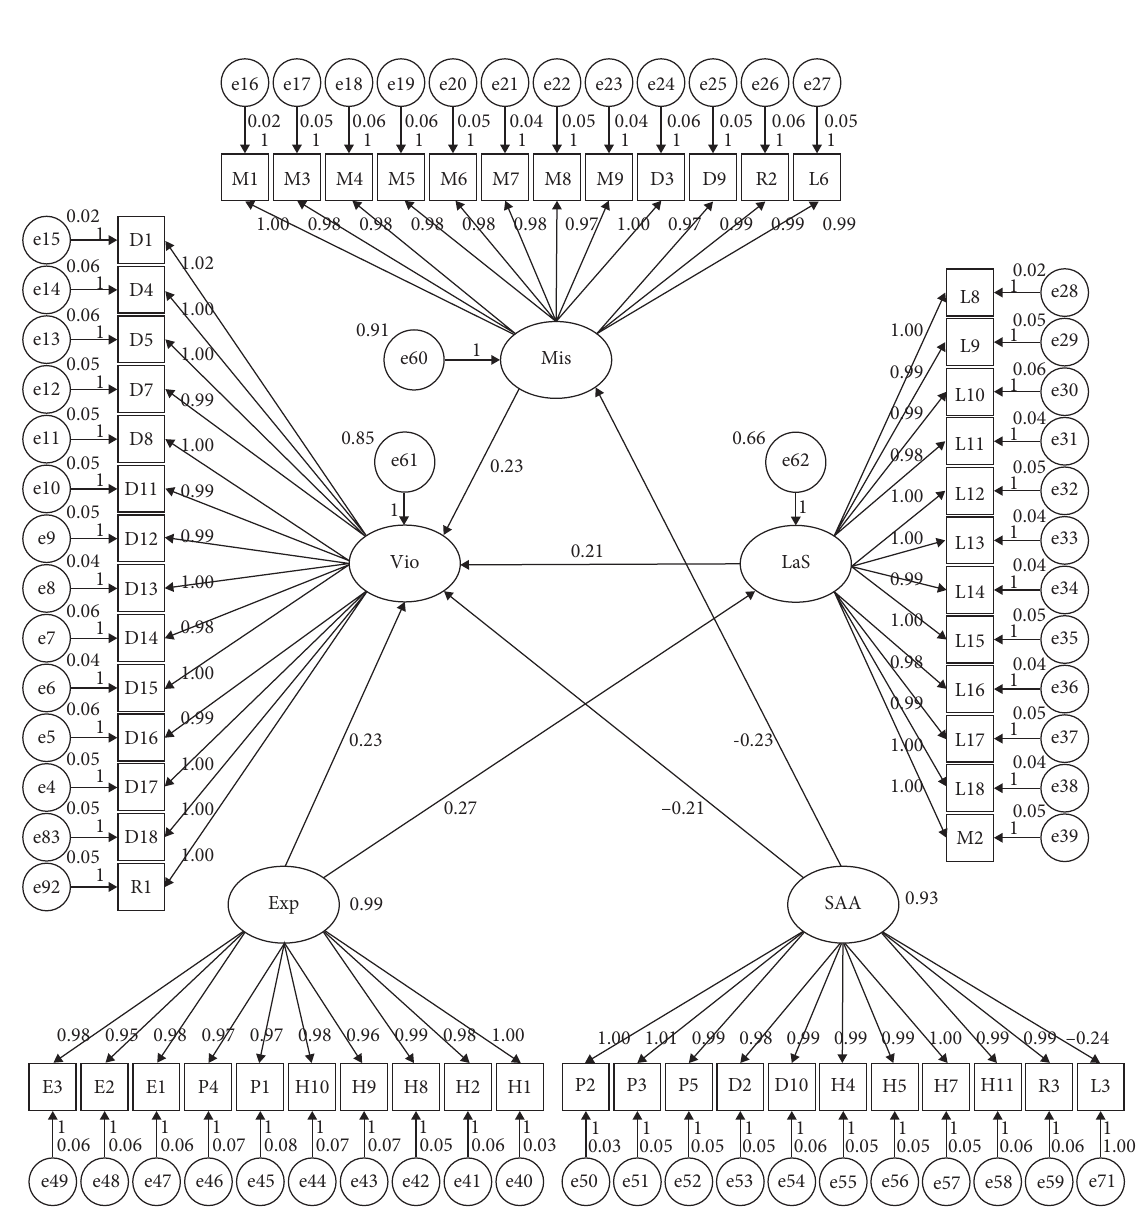
Figure 4: Driving behaviour analysis